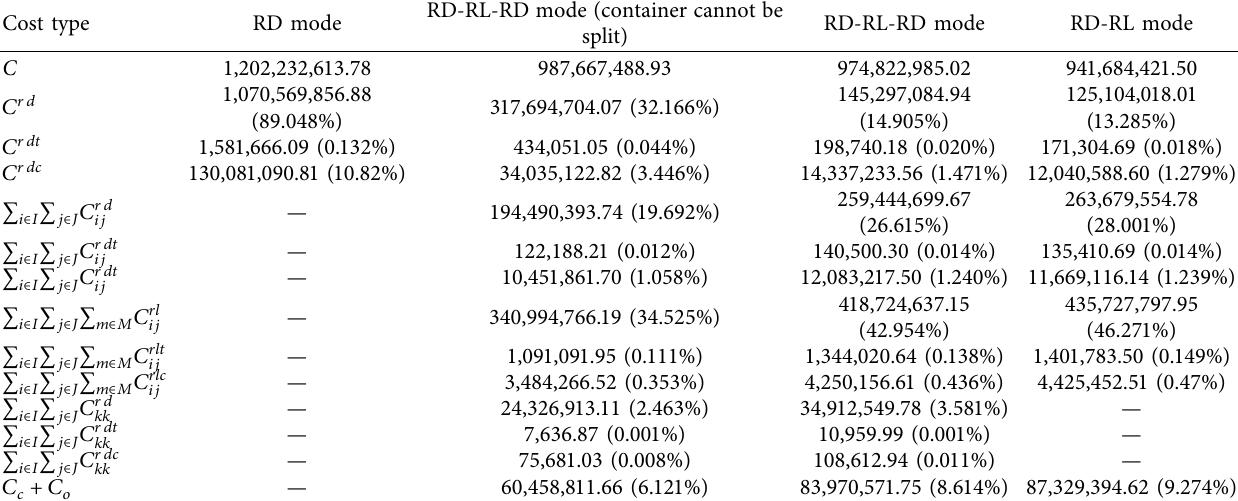
Table 9: Cost changes under the different transportation modes (unit: